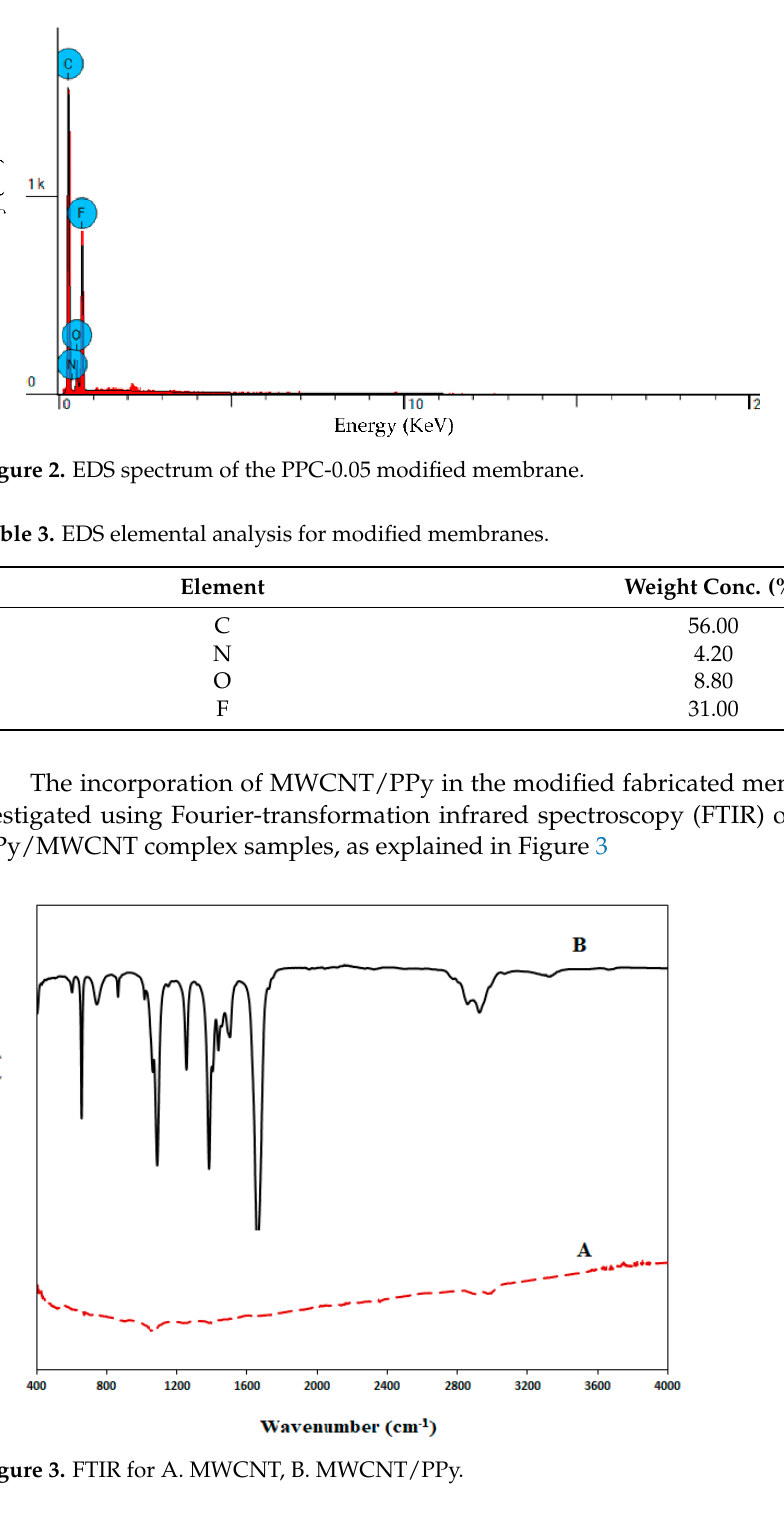
Figure 3. FTIR for A. MWCNT, B. MWCNT/PPy.